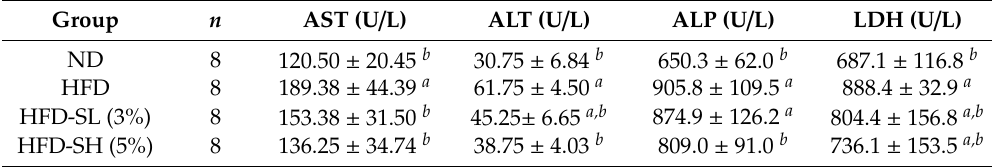
Table 4. E ff ects of the Spergularia marina Griseb powder (SMP) on the liver